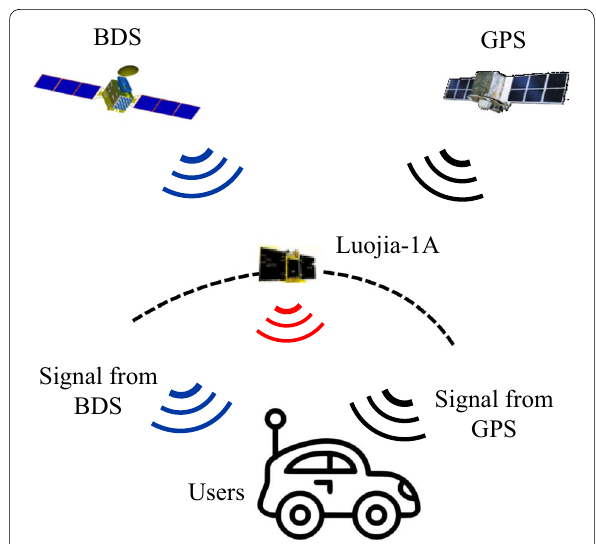
Fig. 9 Principle of the Luojia-1A augmentation